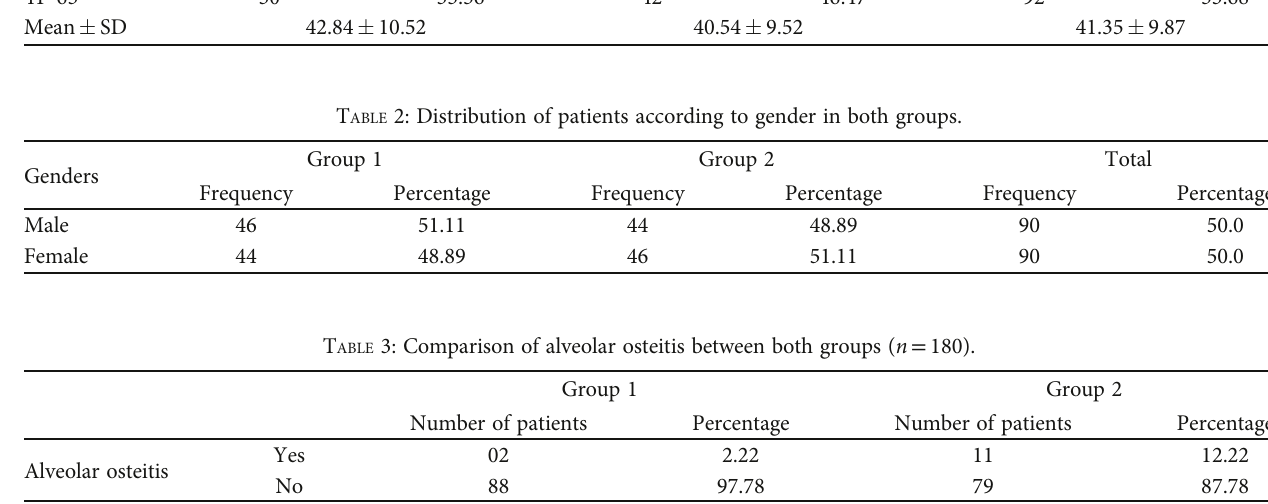
p -Value is 0.010, which is statistically signi fi cant.